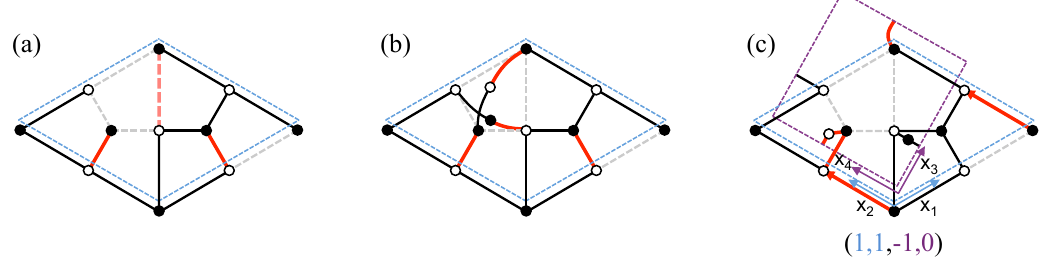
Figure 26. An example in phase 1 of dP 3 . a) The original perfect matching. b) Backreaction including bridges. c) Explicit introduction of the corresponding genus 1